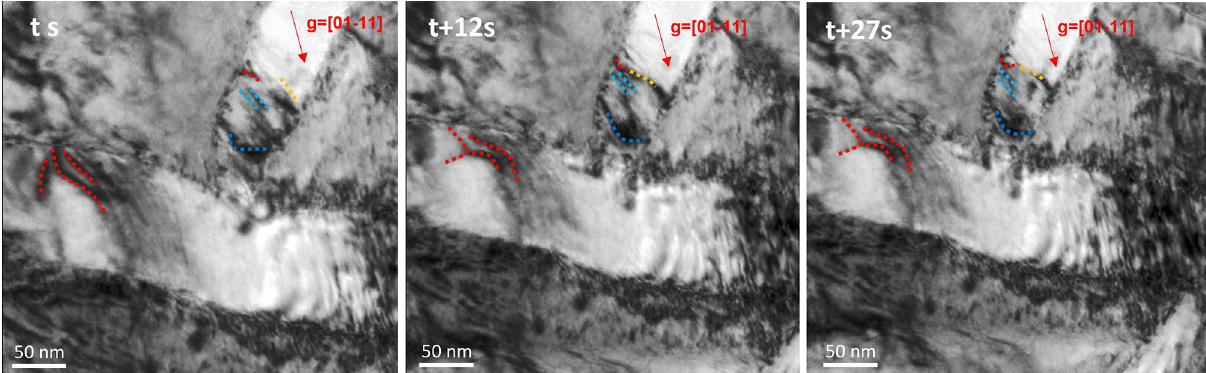
Figure 2. Transportation of dislocation activities between different α plates. Serial TEM images showing dislocation glide along the longitudinal direction of each α phase.